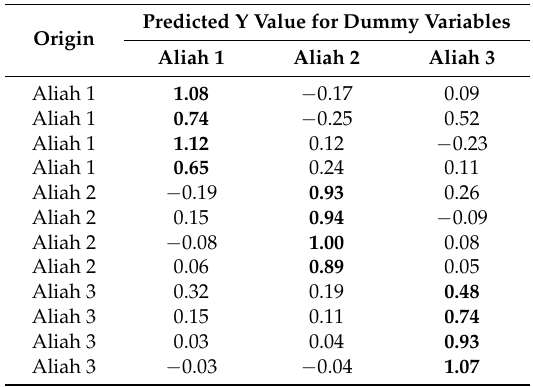
Table 1. Classification of membership list for the discriminant analysis